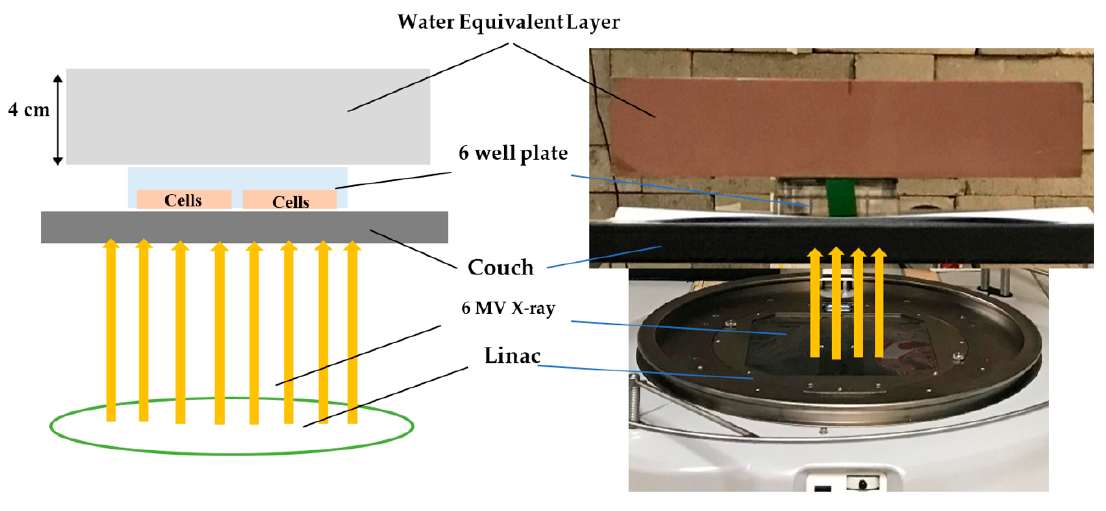
Figure 11. Cell irradiation setup .